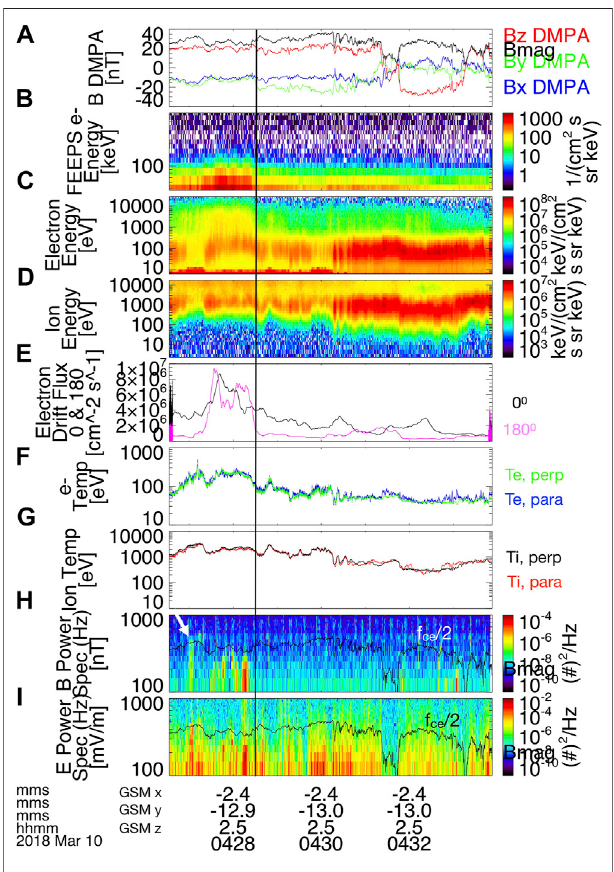
FIGURE 2| A fullday plot ofthe sameevent asabove, going from 12:00 on 9 March 2018 to 12:00 on March 10. (A) Magnetic fi eld in GSM coordinates, (B) FEEPS electron energies, (C) Lower-energy electron energies, (D) electron density, (E) Pitch angle distribution of FEEPS electrons in the 40 – 60 keV range, (F) Pitch angle distribution of FEEPS electrons in the 70 – 90 keV range, (G) Electron velocity components in GSE coordinates. The lime green bars on top indicate where burst mode data is available and the gaps in the middle are from the FPI instruments turning off in the inner magnetosphere. The vertical line indicates where Figure 1 begins, which is located at a distance of 13.4 R e